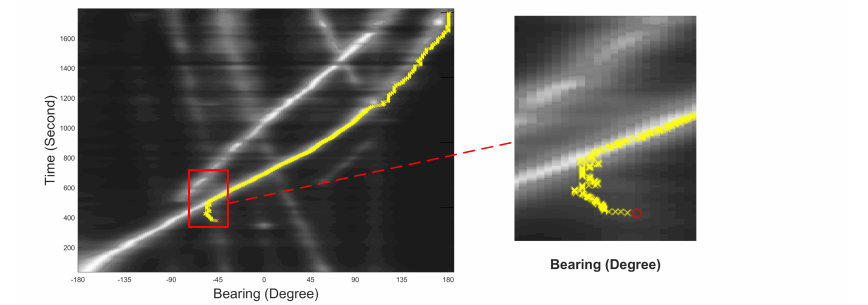
Figure 14. Observation Window of jamming